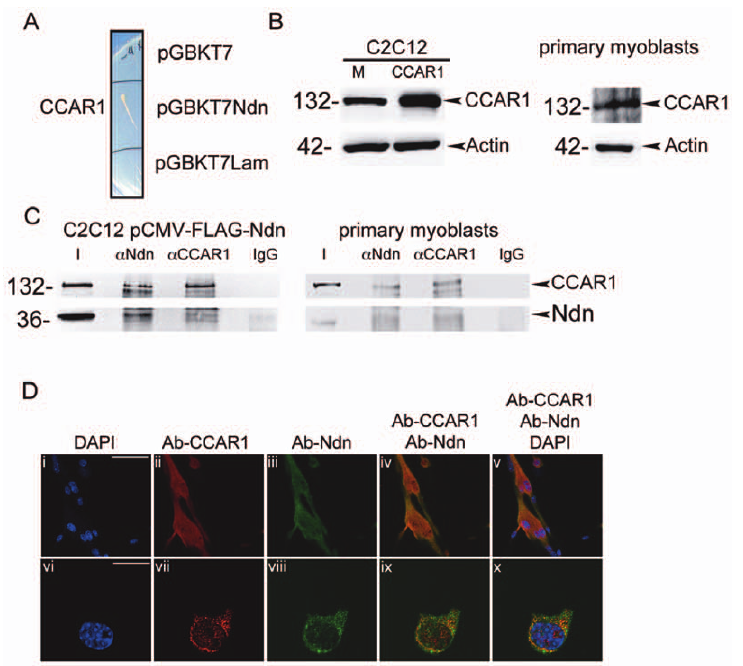
Figure 1. Necdin interacts with CCAR1/CARP1. A) Necdin interacts with CCAR1 in yeast in mating experiments. The plasmid pGBKT7-containing either the cDNA sequence for necdin, laminin (as unrelated sequence) or the empty vector (as negative control) were transformed in Y187 mat- a while AH109 mat-a cells were transformed with the plasmid pGAD-Rec CCAR1 (previously extracted and sequenced from the specific clone of two hybrid in yeast result). After mating only the diploids cells were able to grow on selective medium (SD/-Leu, -His,-Trp, -Ade). B) Representative western blot using antibodies specific for CCAR1 or b -actin as control, in mock-transfected C2C12 (M), C2C12 transfected with pSG5-HA-CCAR1 vector (CCAR1) and in primary myoblasts isolated from C57Bl6 newborn mice. C) Interaction of necdin and CCAR1 in C2C12 myoblasts and primary myoblast cells. Co-IP experiments were performed on protein extract from C2C12 transfected with pCMV-FLAG-Necdin (C2C12 pCMV-FLAG-Ndn) or primary myoblasts from C57/Bl6 newborn mice. Proteins were immunoprecipitated using the polyclonal anti-Ndn ( a -Ndn) or polyclonal anti-CCAR1 ( a -CCAR1) and with a non-specific rabbit antisera as control (IgG). Necdin and CCAR1 were detected in immunoprecipitated samples using specific antibody. Input (I) represents 10% of the immunoprecipitated proteins. D) Co-localization of necdin and CCAR1 in primary myoblasts of wt (C57/Bl6) mice. Images taken at confocal laser scanning miscroscope at 40x (i–v) and 63x (zoomed 1.67 times) magnification. Nuclei are stained with DAPI (i, vi; blue). Panels shows immunostaining experiment using the polyclonal anti-CCAR1 (ii, vii, Ab-CCAR1-red) or monoclonal anti-Ndn (iii, viii; Ab-Ndn-green). Panel iv shows the merged images of ii and iii and panel ix the merged images of vii and viii (Ab-CCAR1 + Ab-Ndn-yellow). Panel v shows the merged images of i, ii and iii and panel x the merged images of vi, vii, viii, (Ab-CCAR + Ab-Ndn + DAPI). Scale bar (i–iv) =17 m m; (vi–x) =41,75 m